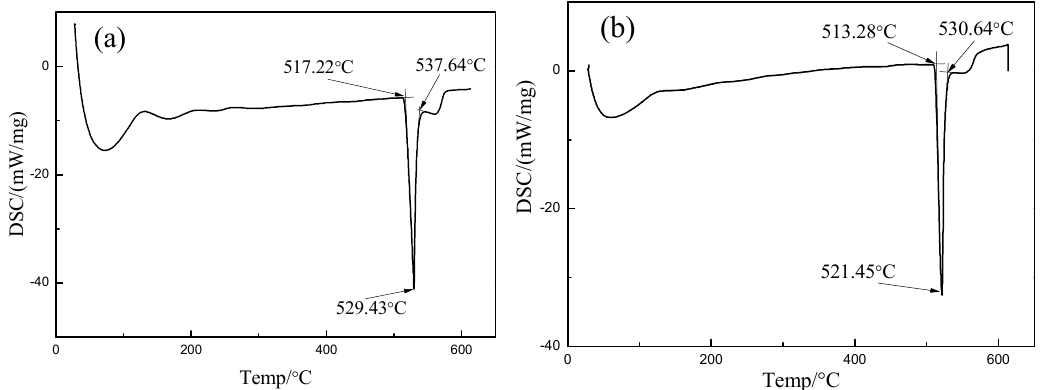
Figure 5. DSC curve of the brazing filler metal alloy: ( a ) as-cast brazing filler metal; ( b ) foil-like brazing filler metal.